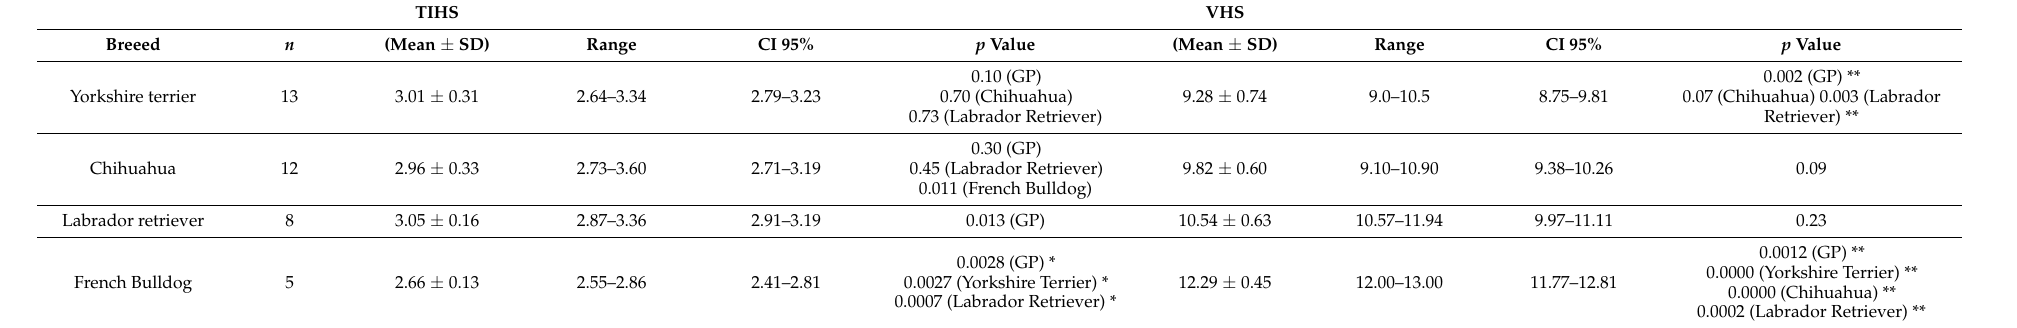
Table 2. Mean (SD), range, and 95% Confidence Interval (CI) for measurements of the cardiac size on right lateral thoracic radiographic projection obtained from 48 normal dogs of four different breeds. p <